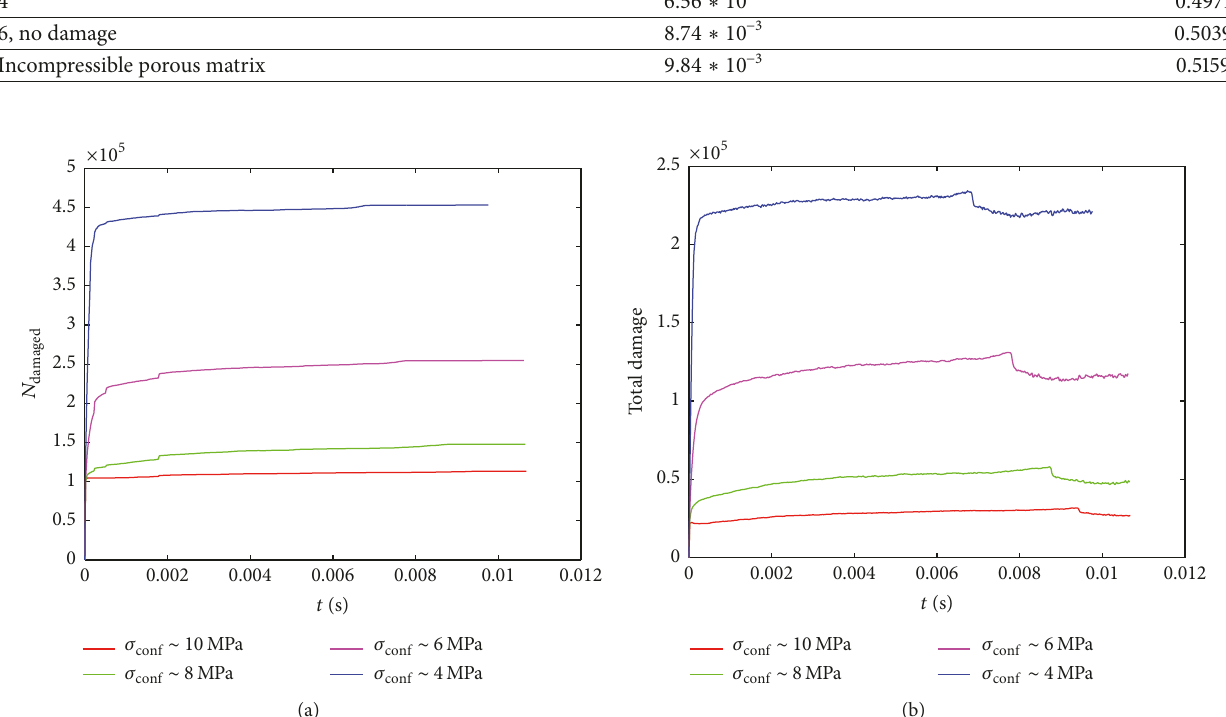
Figure 10: (a) Number of damaged elastic SPH particles. (b) The total damage calculated as a sum over all the damaged